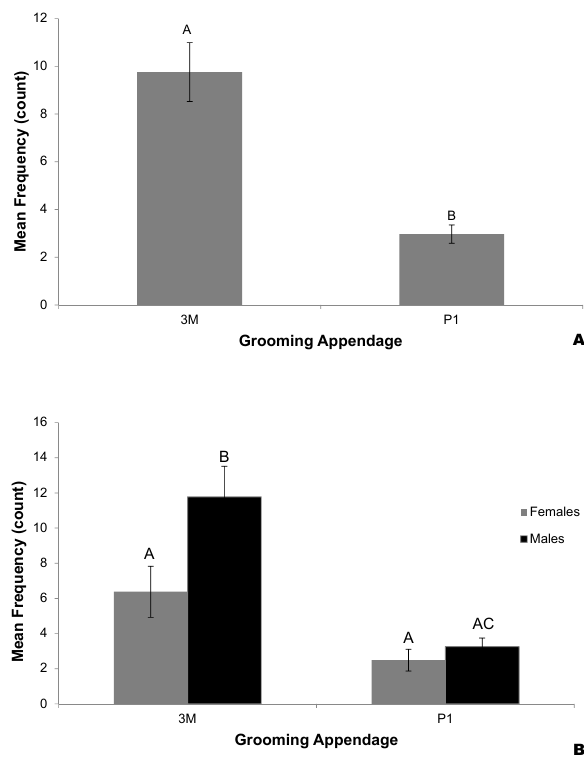
Figure 4. Mean frequency of grooms, with standard error bars, by grooming appendages in 30-min isolation observations (N=142). A. Mean frequency of grooms for each of the grooming appendages, with genders combined (z=3.39, p<001). B. Mean frequency of grooms for each of the grooming appendages, with the genders separated; males groomed with their 3M more than P1 (z=3.23, p=0.001) whereas females groomed with the 3M and P1 appendages equally (z=1.40, p=0.140). 3M, third maxilliped; P1, pereiopod #1 (cheliped). Note: Similar letters indicate no statistical significance (p>0.05) and different letters indicate a statistical significance (p<0.05).